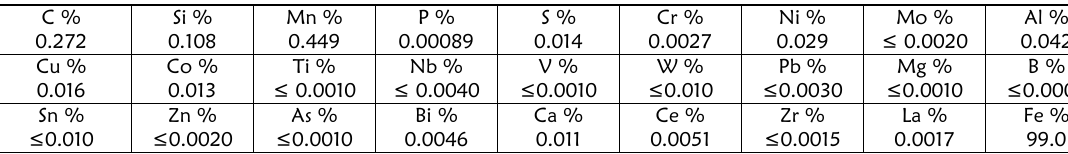
Table 2: Chemical composition of medium carbon alloy steel